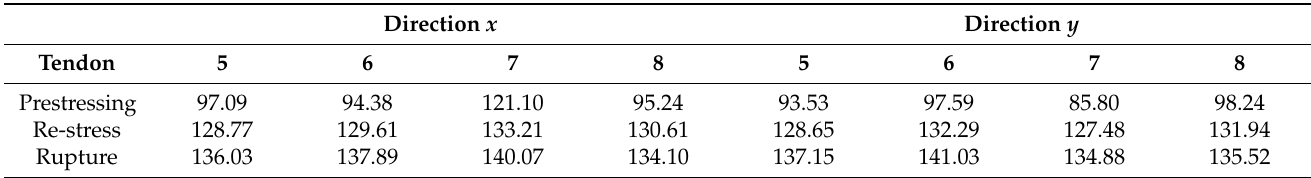
Table 2. Prestressing force on tendons (kN)